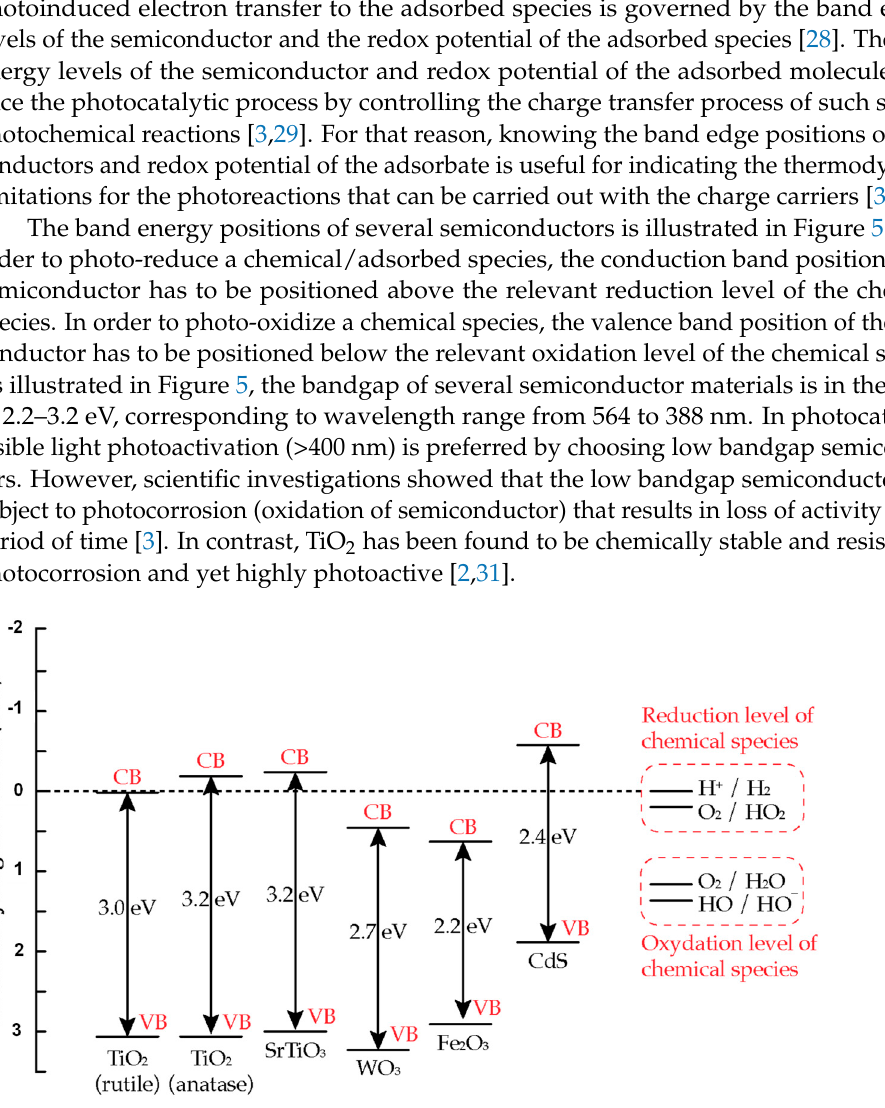
Figure 5. Valence and conductance band positions for various semiconductors and relevant redox couples at pH 0. couples at pH